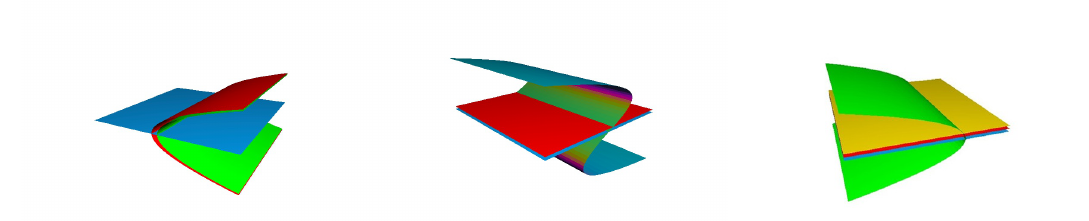
Figure 12 . Degree five spectral covers with non-reduced